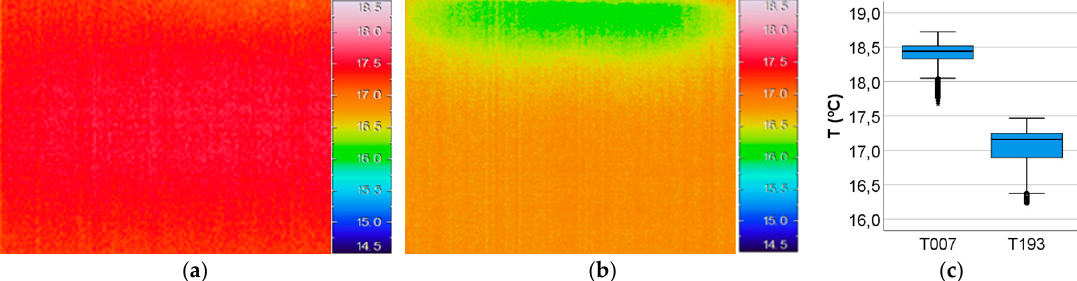
Figure 1. Reference thermal images: ( a ) At the initial instant (T007); ( b ) At the final instant (T193); ( c ) Boxplots representations.